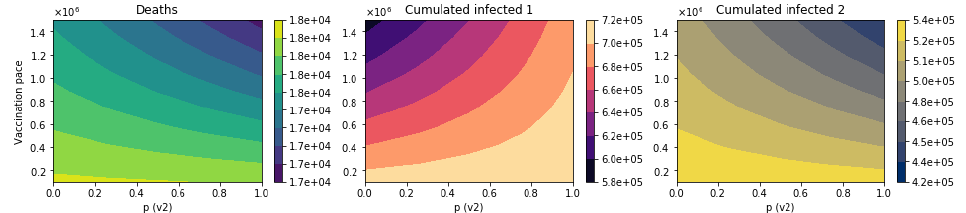
Figure 7. Total number of deaths and the cumulative number of infected people for each age group. This scenario considers a relatively low SARS-CoV-2 transmission rate and vaccine efficacy of 90%. The factors that are varied are the vaccination pace and the proportion of vaccines allocated to each age